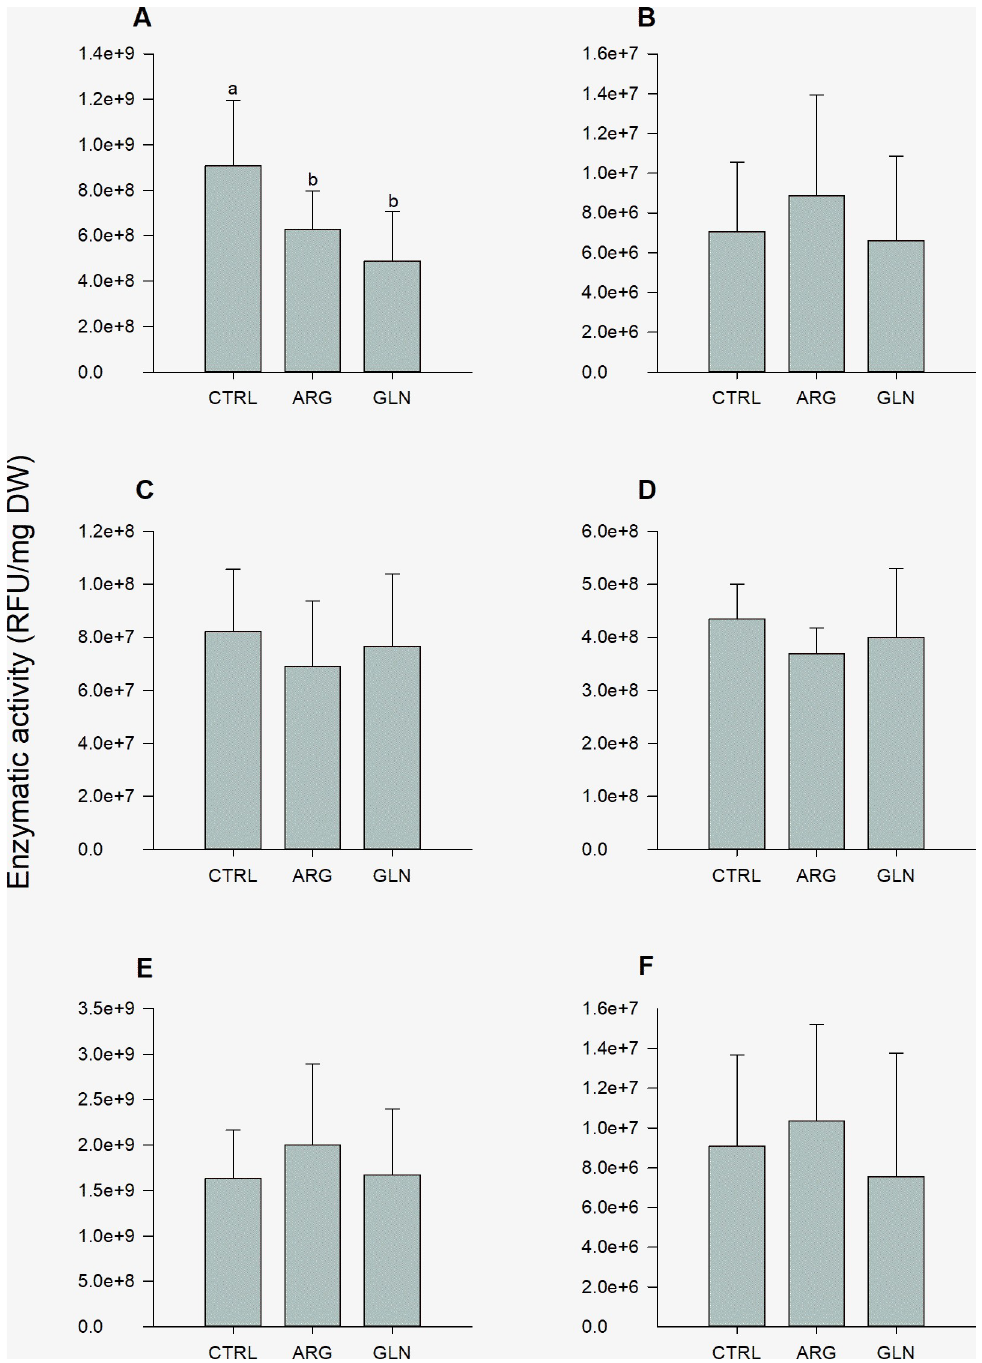
Fig 3. Digestive enzyme activities in zebrafish larvae. Trypsin (A), chymotrypsin (B), aminopeptidase (C), alkaline phosphatase (D), 7C-like lipase (E) and 18C-like lipase (F) activities in zebrafish larvae (22 dpf) from control (CTRL), arginine (ARG) and glutamine (GLN) treatments. Activity values are expressed as RFU/mg larval dry weight. Results are represented as means ± SD ( n = 6). Different letters (a,b) indicates significant differences between treatments (P < 0.05).